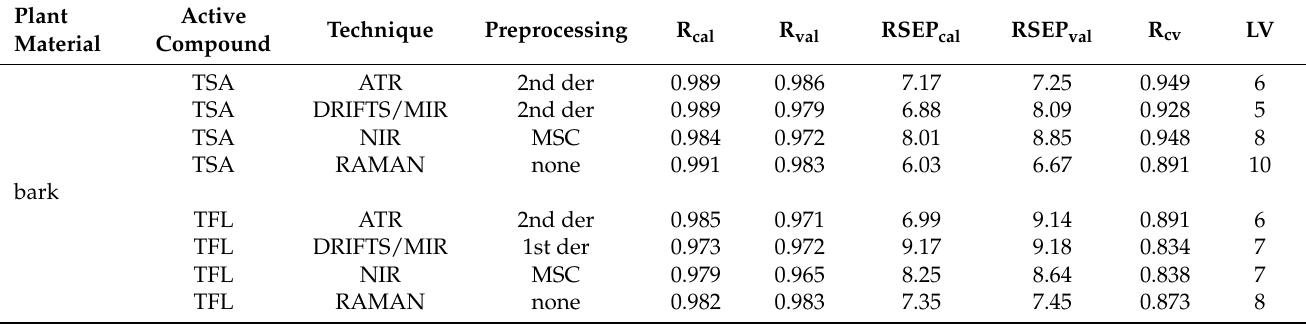
Table 1. Calibration parameters of the TSA and TFL content modeling in the poplar